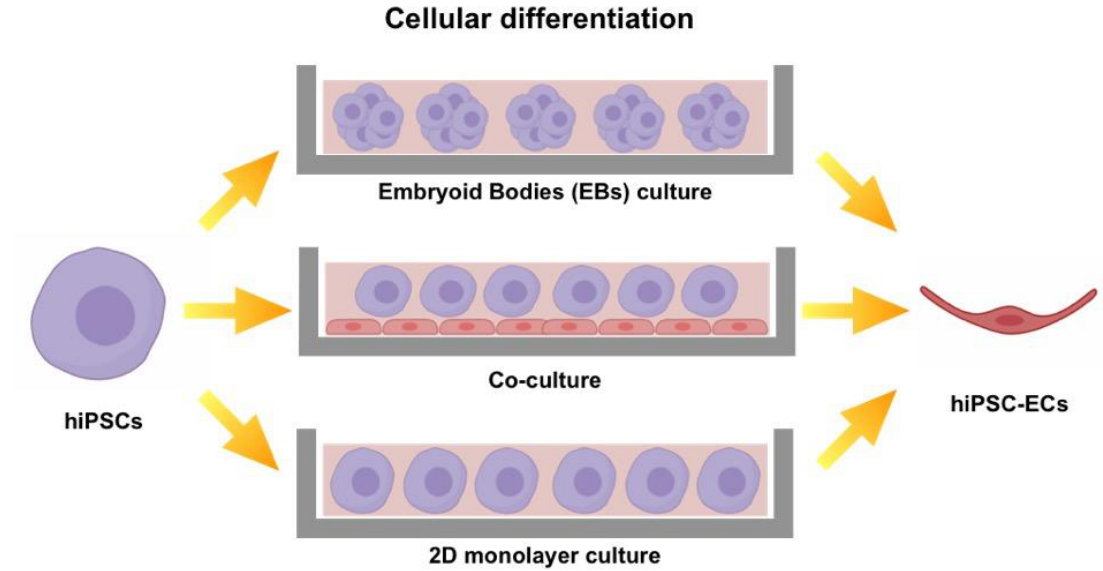
Figure 4. Illustration of the main strategies used to differentiate hiPSC into hiPSC-ECs. Embryoid Bodies (EBs): cultured in suspension hiPSCs tend to auto-aggregate in embryoid bodies. Co-culture: hiPSCs are co-cultured with cells able to guide their differentiation into the mature phenotype. Two-dimensional (2D) monolayer culture: hiPSCs are seeded on matrix-coated plates where they are induced to differentiate.